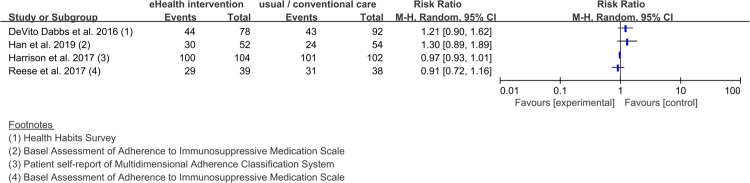
Forest plot without a pooled estimate demonstrating the effectiveness of eHealth interventions for medication adherence in organ transplant patients.The four studies presented here used subjective methods to measure medication adherence in organ transplant patients and presented the results as dichotomous data.